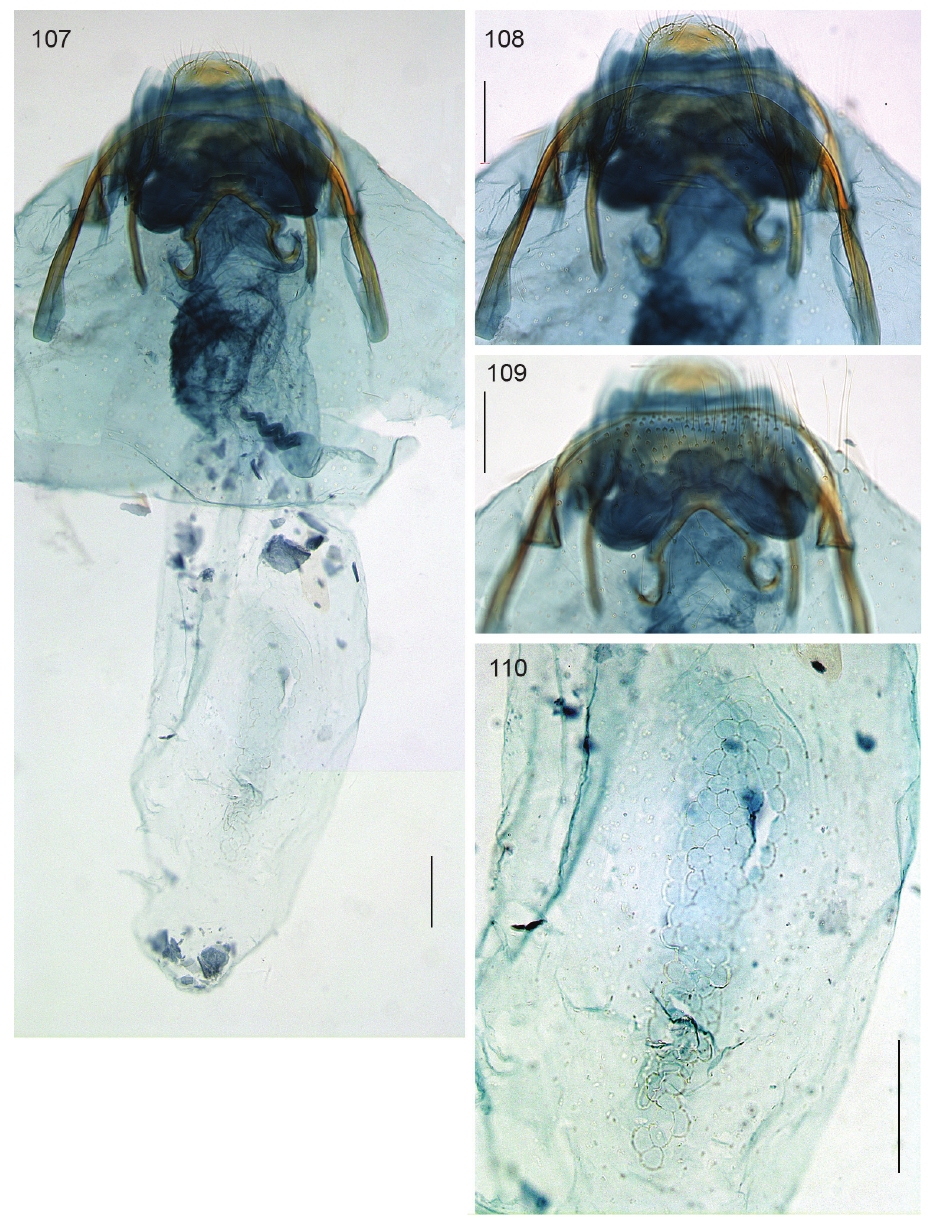
Figures 107–110. Neotrifurcula specimen EvN4504, female genitalia, slide EvN4504. Scale bars: 100 µm.